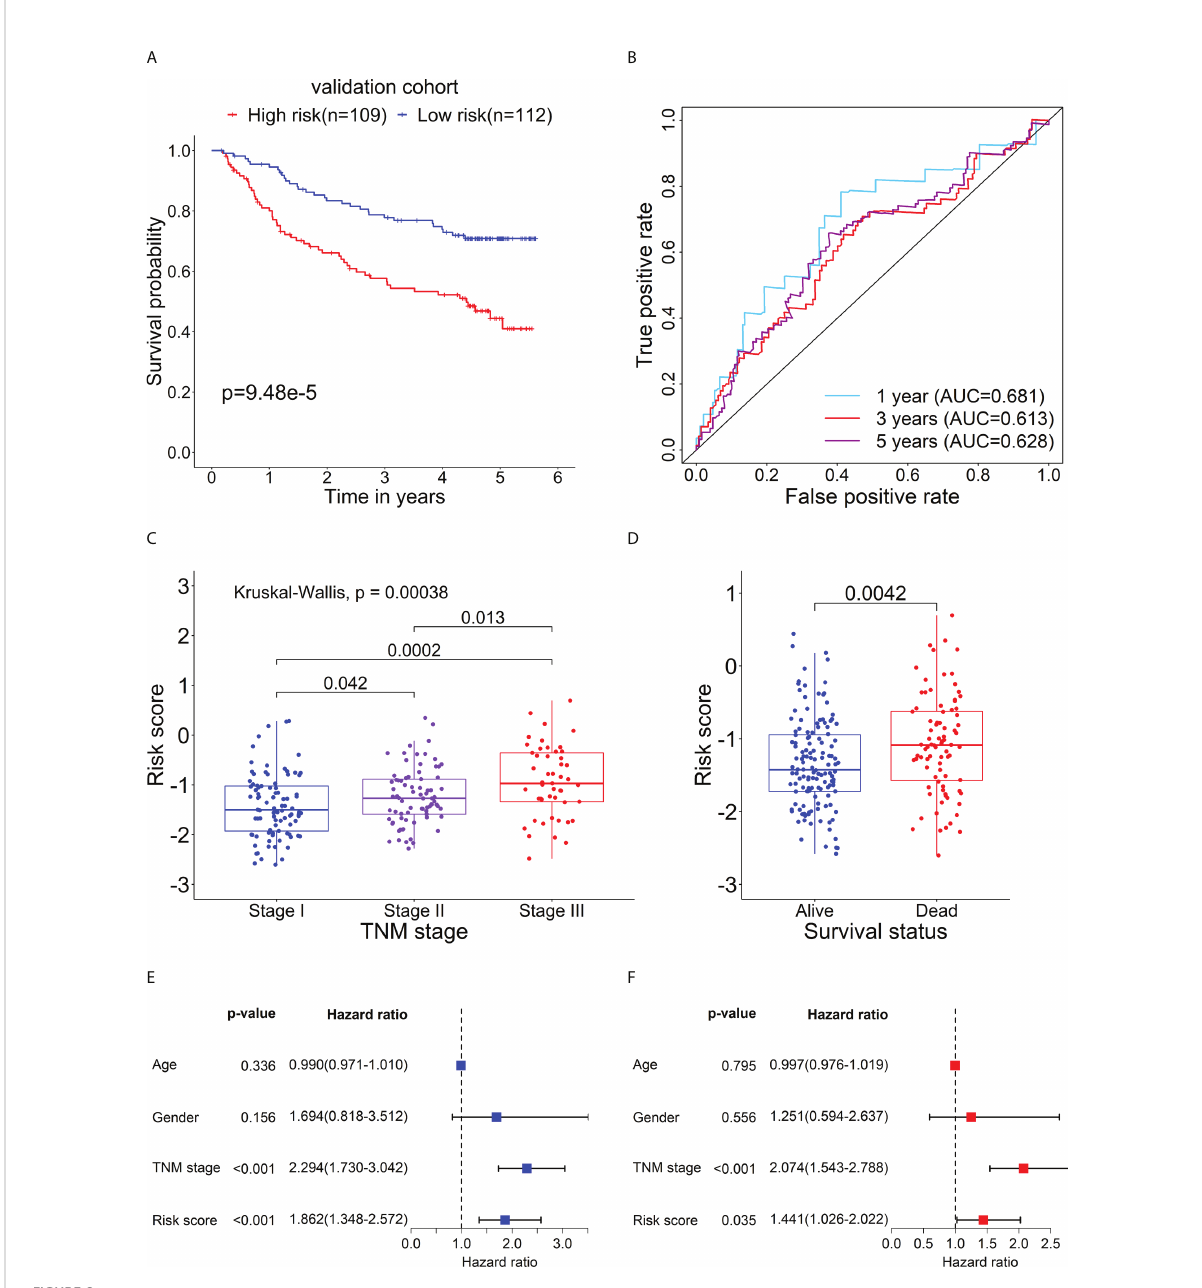
FIGURE 8 Veri fi cation for the prognostic performance of the RBP-related risk model in the validation cohort. (A) Kaplan – Meier curve shows the difference in OS between the high- and low-risk groups in the validation cohort. (B) The 1-, 3-, and 5-year ROC curves based on the risk score show the accuracy of the prognostic prediction of the RBP-related risk model. (C) The box plot shows the difference in risk scores of patients with different TNM stages. (D) The box plot shows the difference in risk scores of patients with different survival statuses. Forest plots of the univariate (E) and multivariate (F) Cox regression analyses of risk score and clinical characteristics in the validation